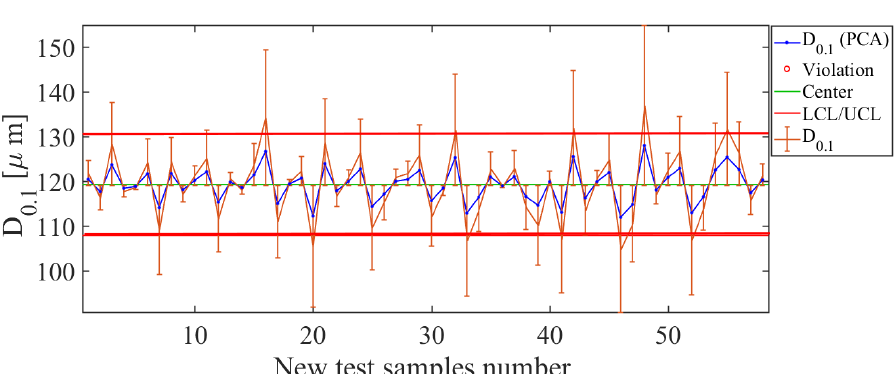
Figure 15. Soft-sensor responses (control chart and error bars) for the D 0.1 descriptor. Best estimates are in the range 100 µ m to 135 µ m, which is consistent with the drop diameter values that is found in practice.